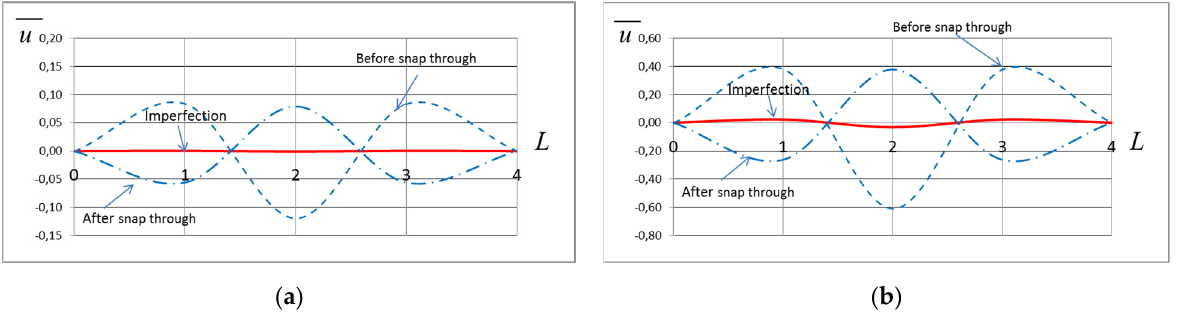
Figure 12. Configuration of displacement before and after snap-through for initial amplitudes of geometrical imperfections developed according to the third buckling mode: ( a ) small ( m 3), ( b ) large ( d 3).